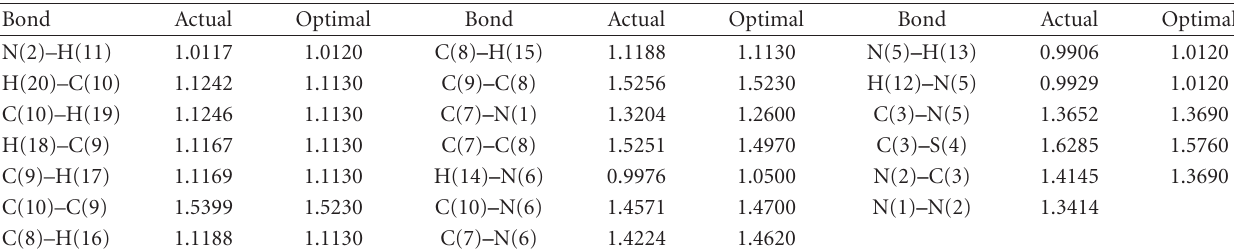
Table 3: Bond lengths of the ligand.